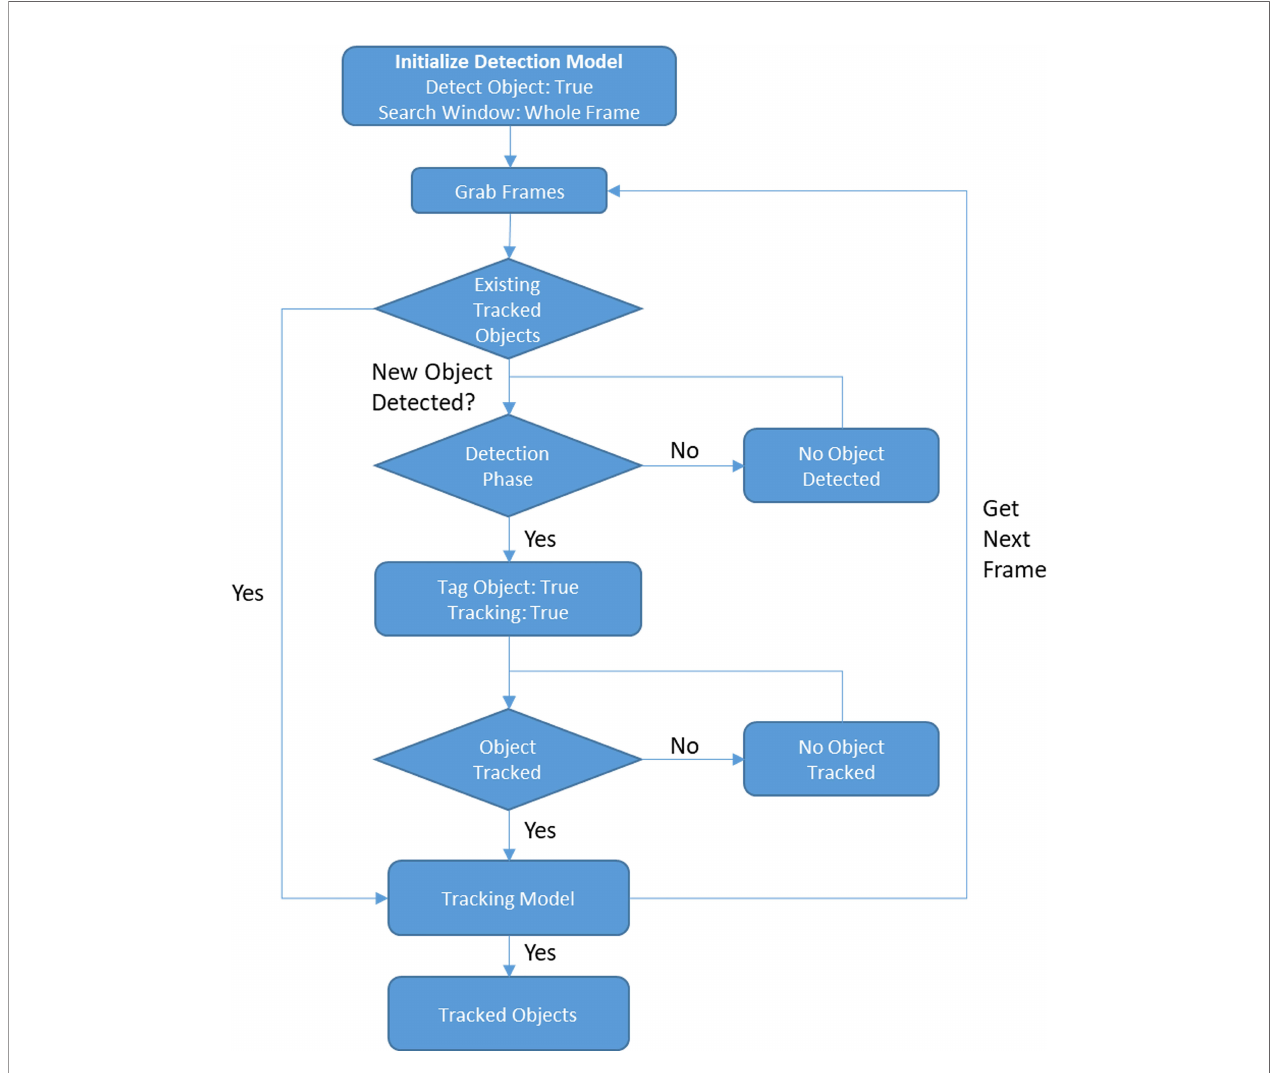
FIGURE 2 | Overall steps for detection and